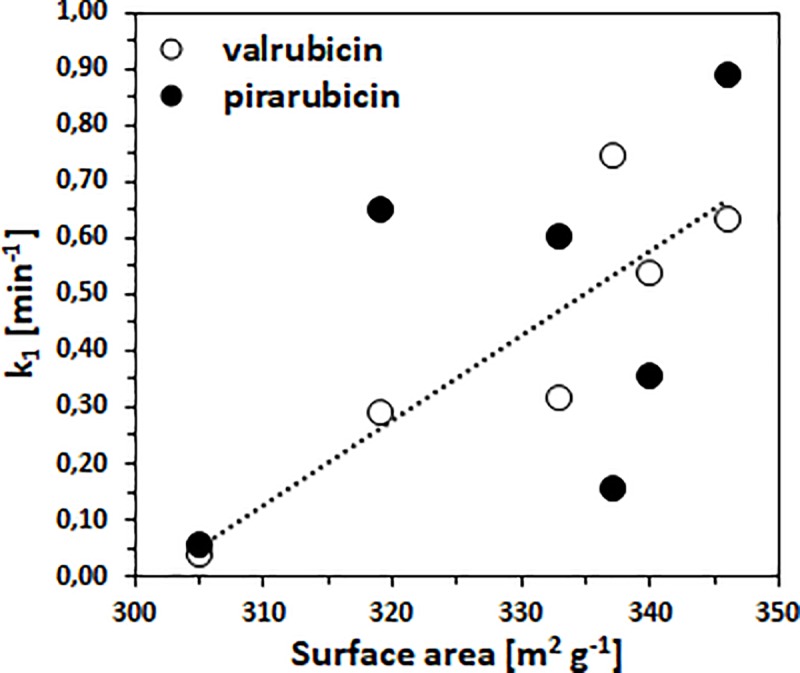
Dependence of k1 (min-1) versus surface area (m2 g-1) of prepared TiO2 samples.